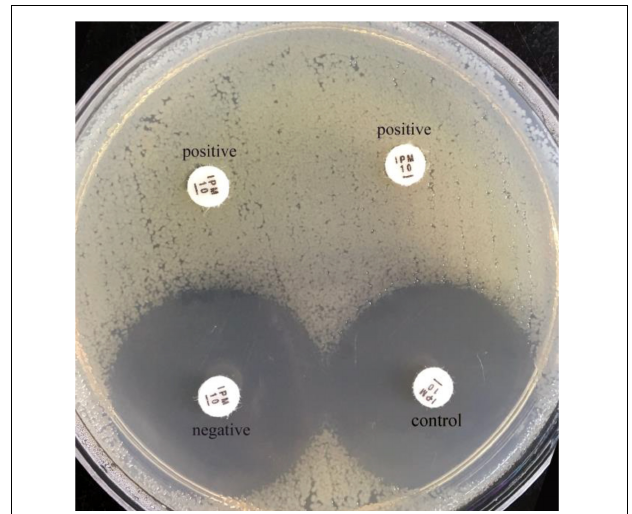
FIGURE 2 | Results of sCIM testing of gram-negative bacilli. The zones of inhibition of the negative isolate and the control were similar, whereas the zones of inhibition of the positive isolates (the left is a K. pneumonia producing KPC-2; the right is an E. coli producing NDM-1) were 6 mm.